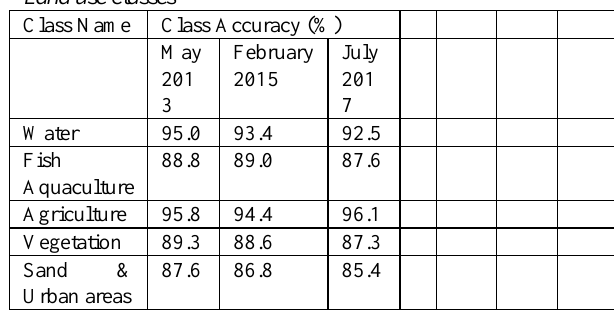
Table (3) Extracted Areas for each Lake Burullus